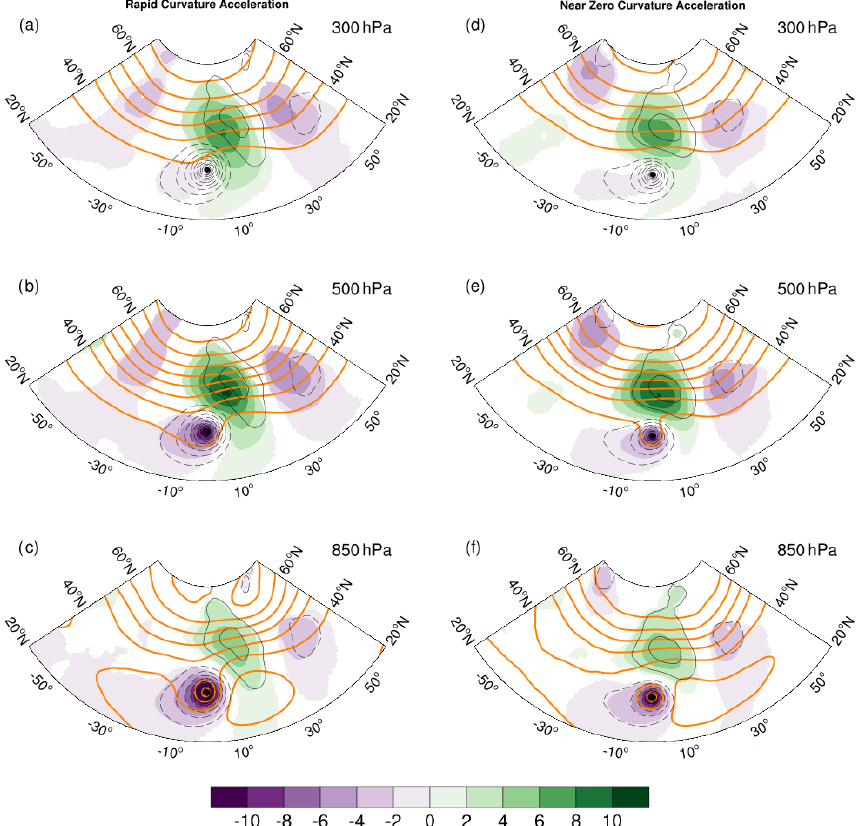
Figure 6. As in Fig. 3 but for rapid and near-zero curvature acceleration.